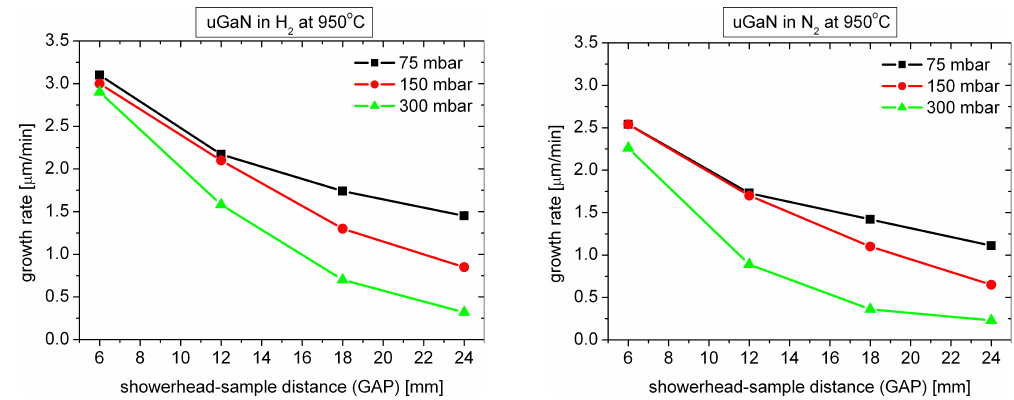
Figure 3. Growth rate of uGaN layers as a function of GAP distance for three different growth pressures.